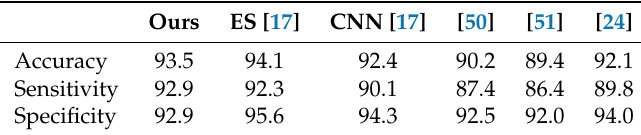
Table 7. Effectiveness of glaucoma diagnosis for RIM-ONEr3 [28]. Ours refers to the ResNet-152-M model. The ES model of [17] model used Entropy Sampling for feature extraction, whereas the CNN of [17] used a CNN. Both ES [17] and CNN [17] used a softmax classifier. The results were adopted from [17].